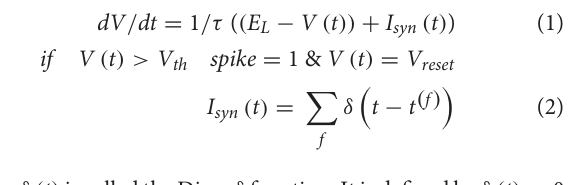
The initial membrane